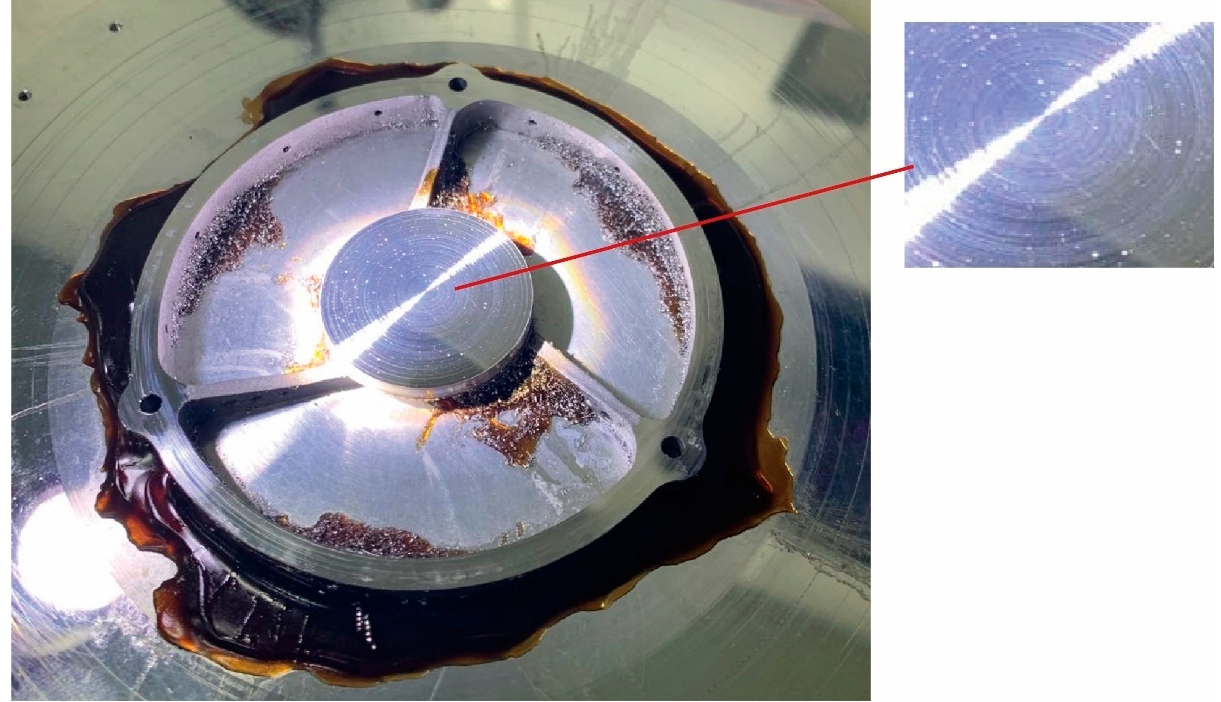
Figure 31. An AM mirror under the light.